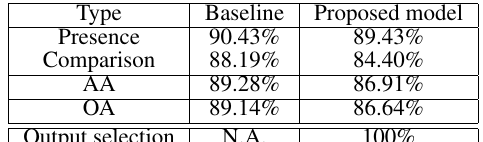
Table 1. Classification results on the test set of the high resolution dataset.